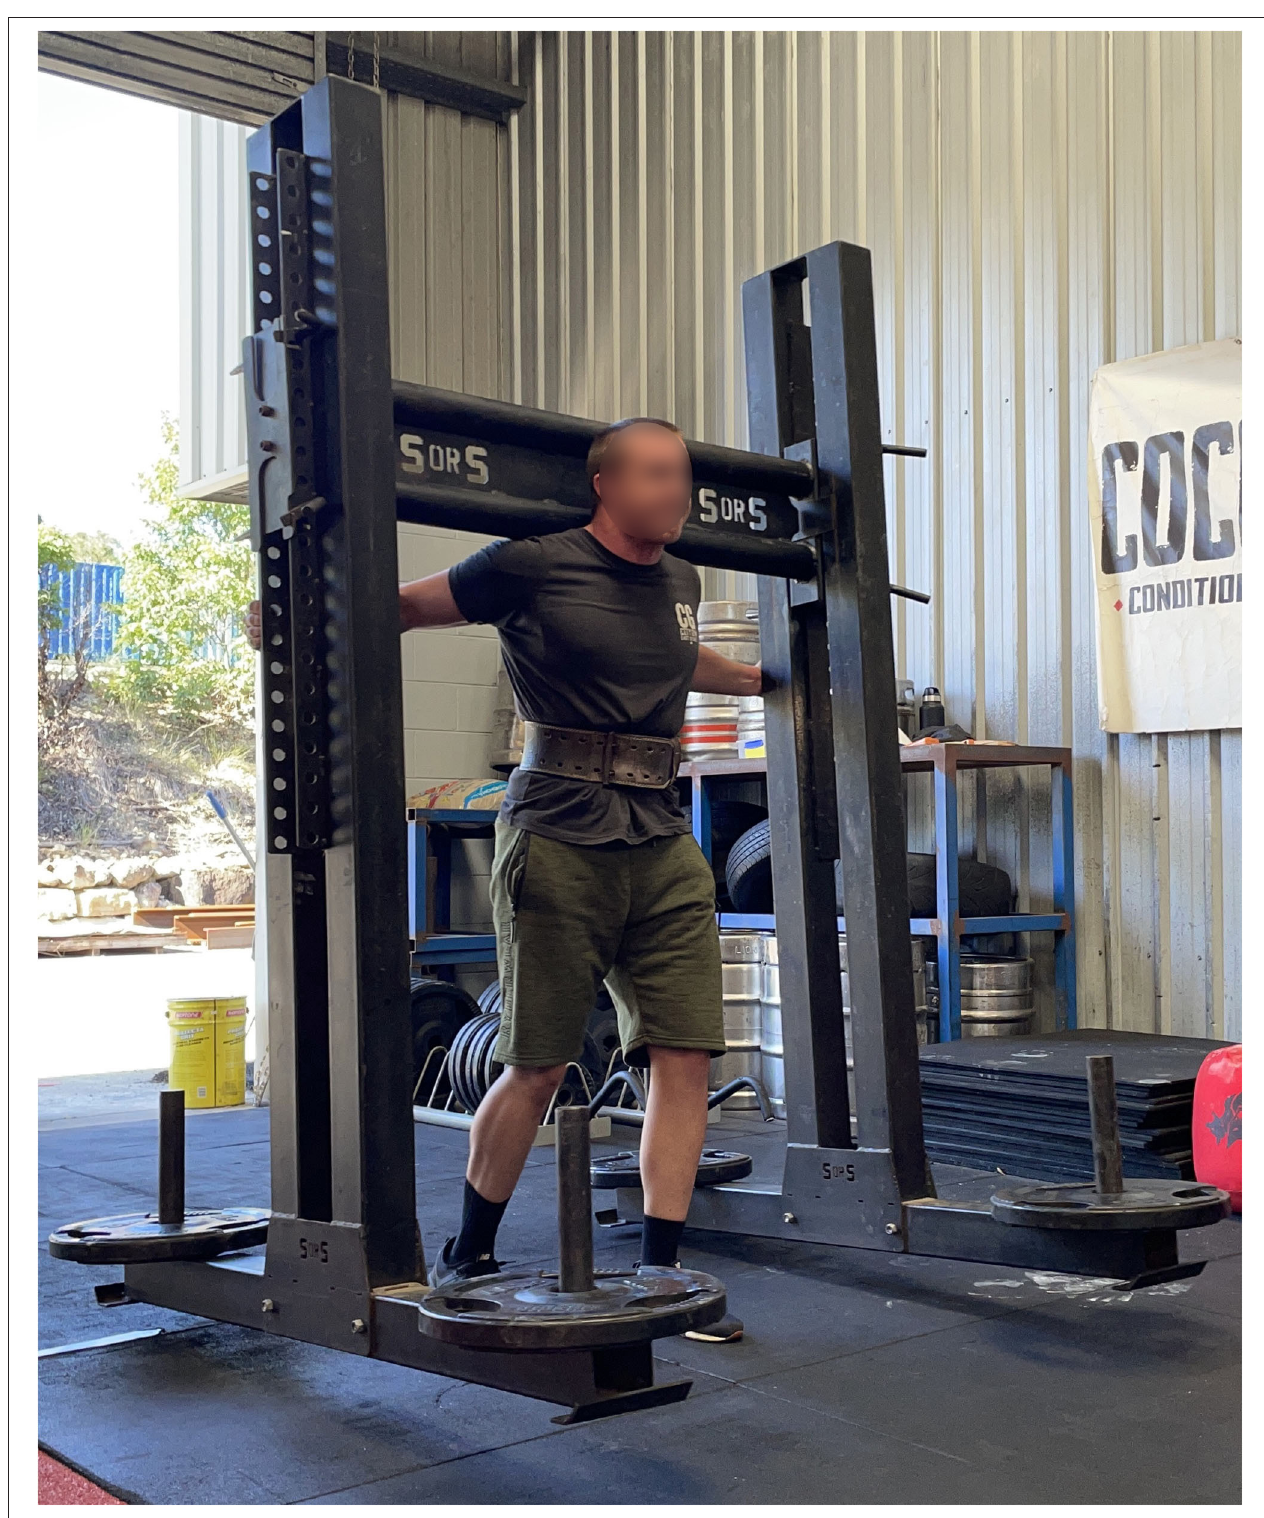
FIGURE 1 | A strongman athlete performing the yoke walk.